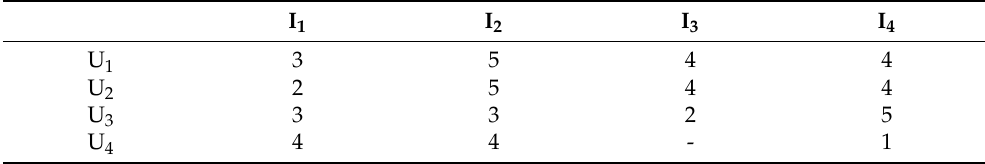
Table 5. An Example.